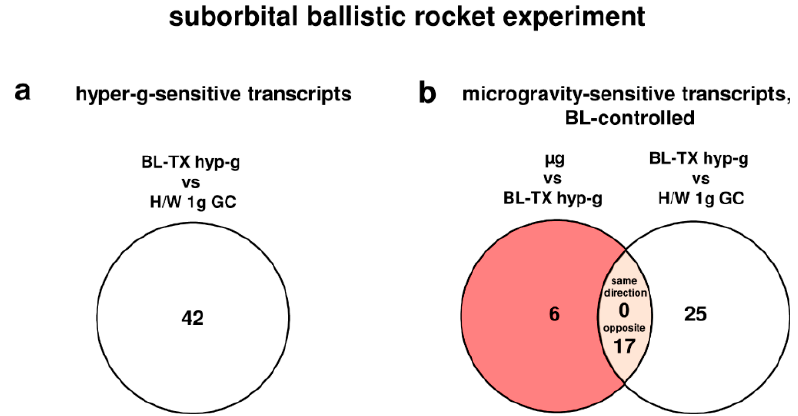
Figure 2. Differentially regulated transcripts (list of genes in Supplementary Table S7) of the oxidative stress response in human U937 myelomonocytic cells during the TEXUS-49 suborbital ballistic rocket campaign. The different comparisons and resulting intersections for hypergravity and microgravity-sensitive transcripts are displayed as Venn-diagramms. In the circles numbers of transcripts are given that are differentially expressed according to fold changes ≤ − 1.3 or ≥ +1.3, p < 0.05. For the abbreviations of the experiment group names see Table 1. Table 4. Number of differentially expressed transcripts in comparisons of the experiment groups of the TEXUS-49 suborbital ballistic rocket campaign. Differential expression is defined as t -test p -value < 0.05; fold change (FC) ≤ − 1.3 or ≥ +1.3. If the ratio is <1, FC is calculated as the negative reciprocal of the ratio. The term “transcripts” refers to 188 oxidative stress-related transcripts of the array, representing 86 genes. For the abbreviations of the experiment group names see Table 1.